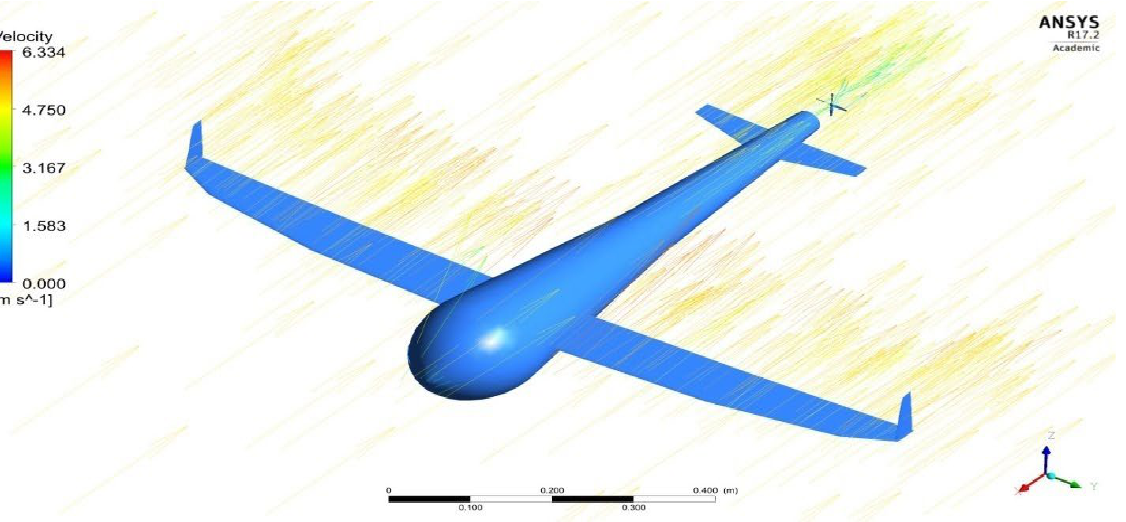
Figure 24. Variations in Equivalent Stress of GFRP-FR-4-Woven.